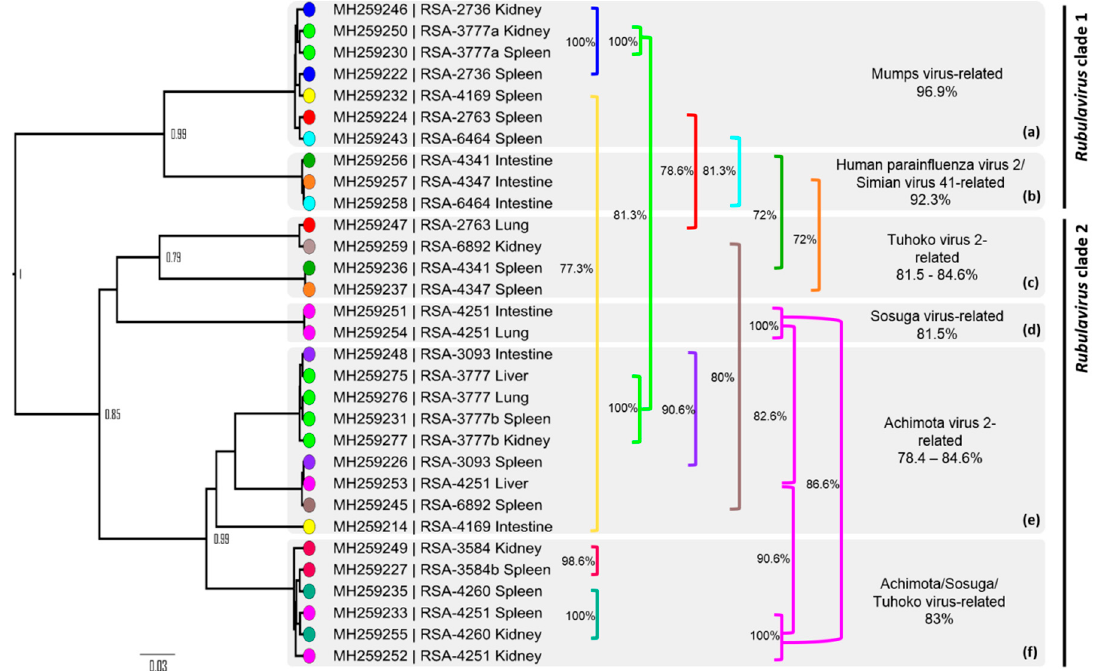
Figure 3. Phylogeny of a 75-amino acid length fragment of the polymerase ( L ) gene of paramyxoviruses detected in various tissues using Avula–Rubulavirus genus-specific primers. Bayesian phylogenetic analysis was performed using the WAG model with a gamma distribution (WAG + G). Organs are color-coded per bat and the amino acid similarity between viral sequences detected per individual bat is indicated in the corresponding colored bracket. Greyed blocks labelled with alphabetical letters indicate sub-clades within the larger two Rubulavirus clades and the highest amino acid similarity per sub-clade to fully characterized paramyxoviruses recognized by the International Committee on Taxonomy of Viruses